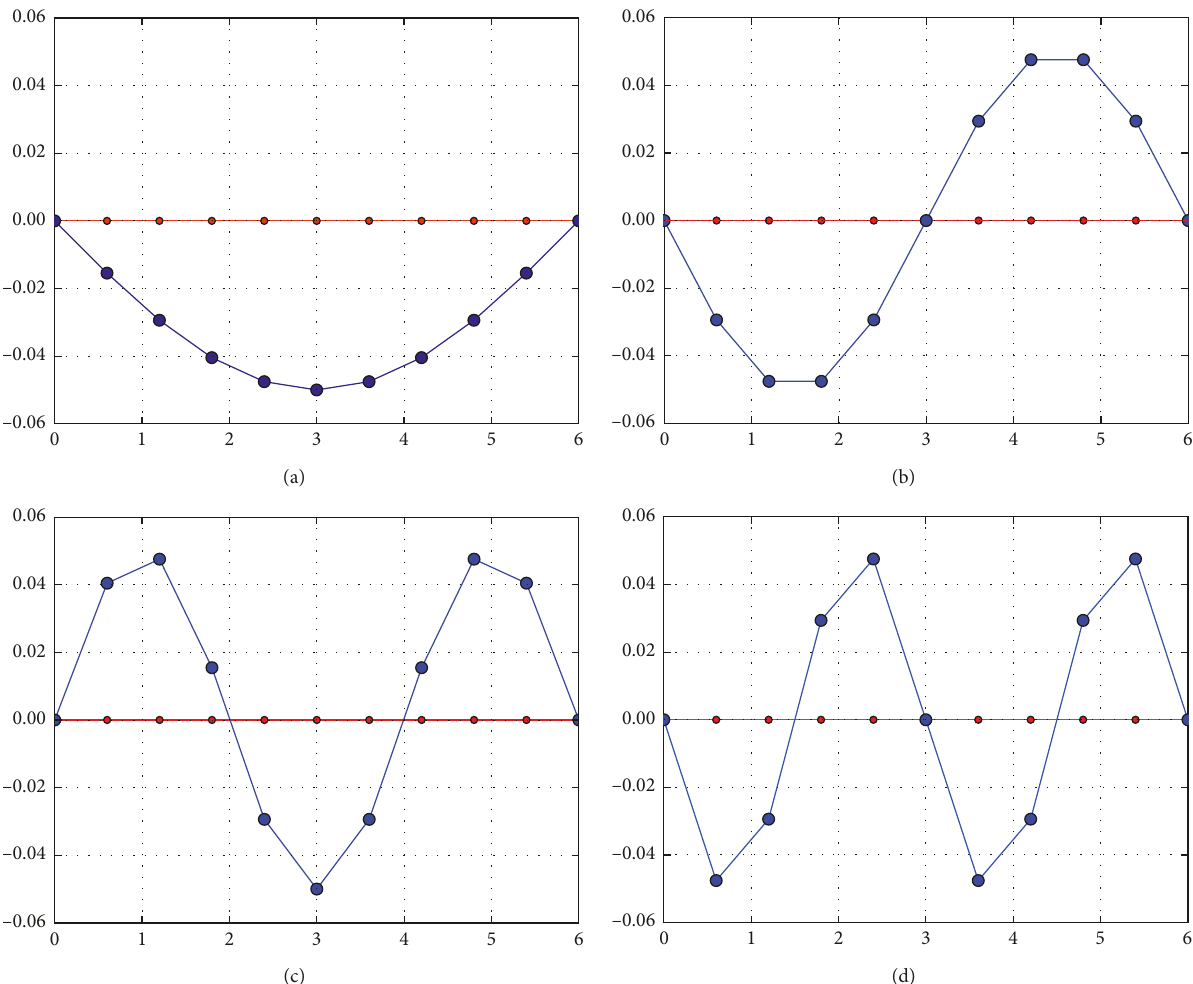
1 (cid:31) 0.115s), (b) eigenmode 2 ( T 2 (cid:31) 0.029s),